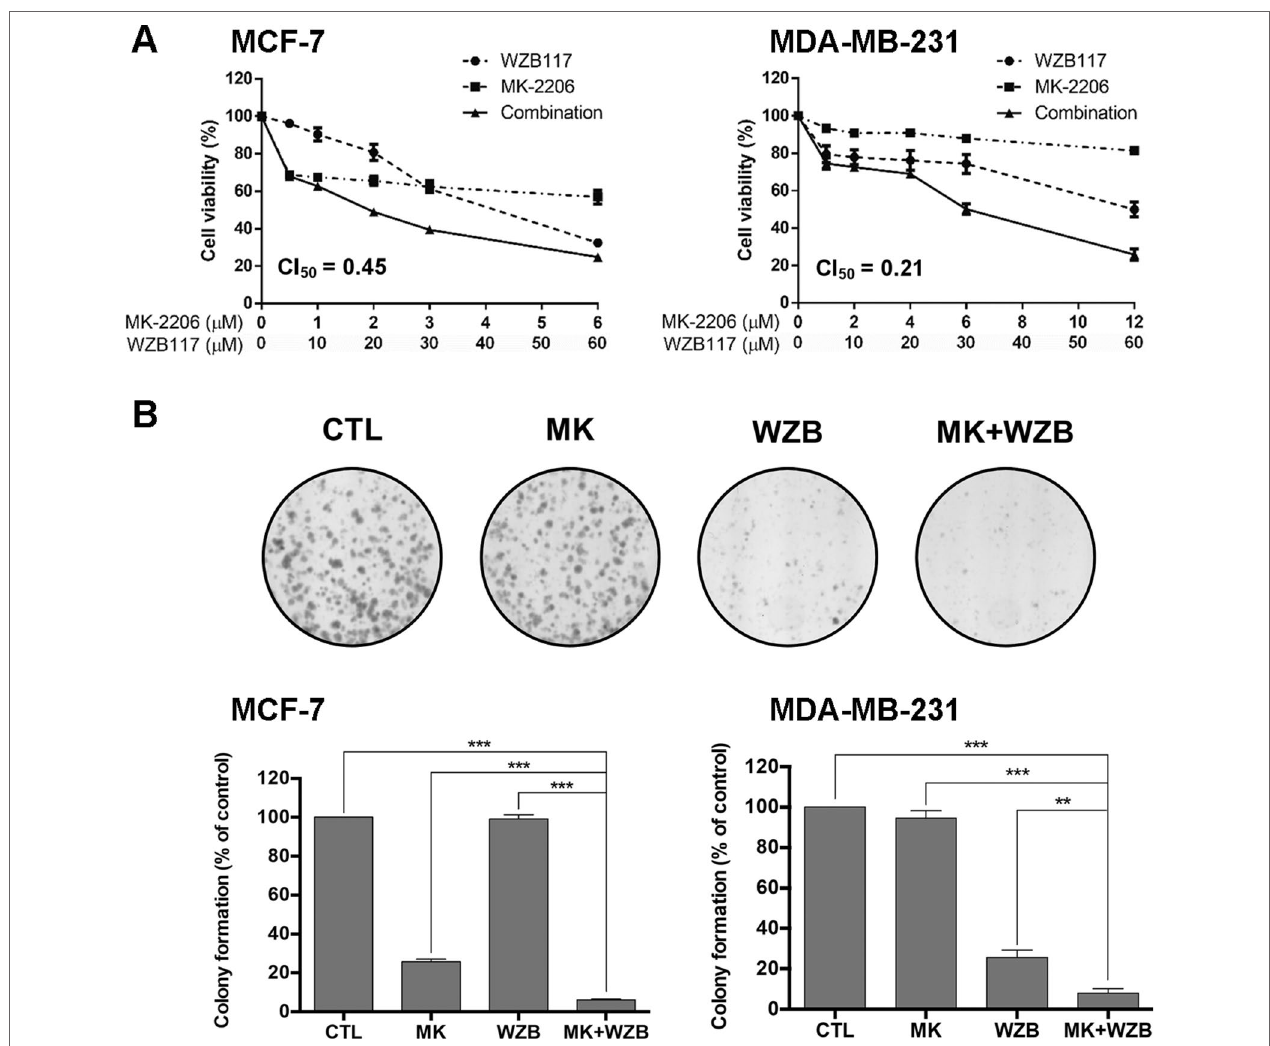
FIGURE 1 | MK-2206 and WZB117 synergistically inhibit the growth of MCF-7 and MDA-MB-231 breast cancer cells. (A) Dose–response curves of cells treated with MK-2206 and WZB117 either alone or in combination for 48 h. Cell viability was measured by the MTT assay. (B) MK-2206 and WZB117 inhibit colony formation. A set of colony formation images of MDA-MB-231 cells are illustrated in the upper panels and quantitative results of colony formation are shown in the lower panels . MCF-7 cells were treated with 0.5 μM MK-2206 and/or 5 μM WZB117, and MDA-MB-231 cells were treated with 6 μM MK-2206 and/or 30 μM WZB117 for 24 h, then cultured in drug-free culture medium for 7 days (MCF-7) or 9 days (MDA-MB-231), and colonies were then scored. CTL , the DMSO vehicle control; MK , MK-2206; WZB , WZB117, MK+WZB , the combination of MK-2206 and WZB117. Data are presented as the mean ± SEM of three independent experiments. ** P < 0.01; *** P <